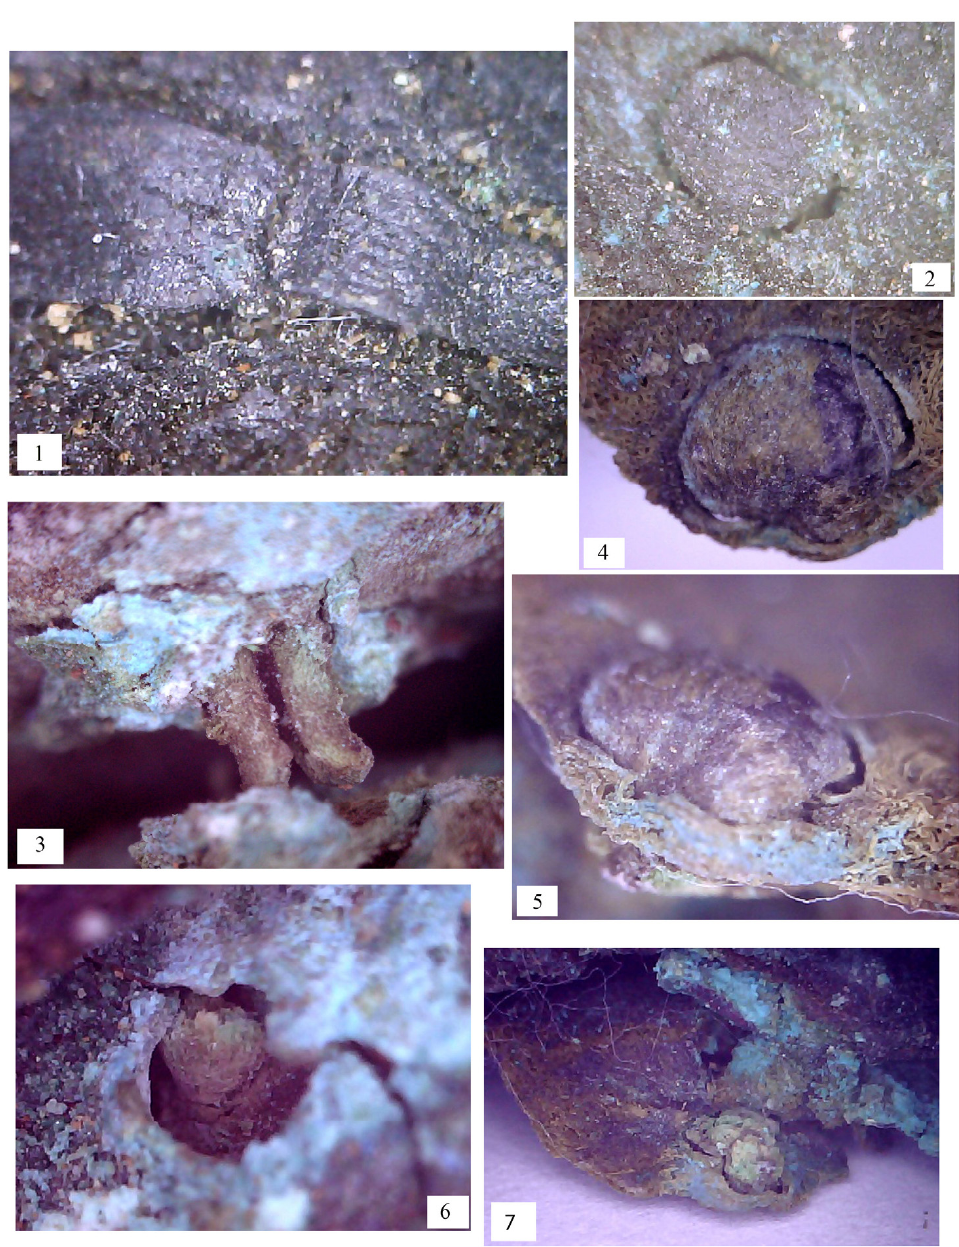
Figure 5. Vodoslavka Barrow 6 Burials 1–2. Stitching on the leather pads with a sinewy strap. Macro photography. Zoom × 20. (1)—Stitch on the outside; (2), (3)–(7)—Stitching of the strap through the leather overlay and metal of the greave; (3)–(7)—Stitching on the inside (photograph S. Didenko). 4. A small fragment of the side edge with three holes for sewing on the lining. On the outside of the greave a small piece of leather lining, measuring 1.5 × 0.7 cm in size, 3. A fragment of the upper left corner from the inner side of the left greave, measuring remained. It was sewed to the greave with a very narrow, flat strap (Figure 6(2)), probably 9.3 × 8 cm (Figure 6(1)). At 0,5 cm from the edge, a series of small holes with a diameter made of sinew. The leather pads that covered the interior openings were sewn to the greave 0.3 cm was pierced at an interval of 0,4–1,6 cm (with filed down burrs around the holes with the same kind of strap (as seen in Figure 4(1),(4)). remaining on the exterior). The holes were for sewing the lining of the greave. 5. Fragments from the sides of the greaves with edging in the form of two parallel lines chased into the surface 0.6 cm from the edge (Figure